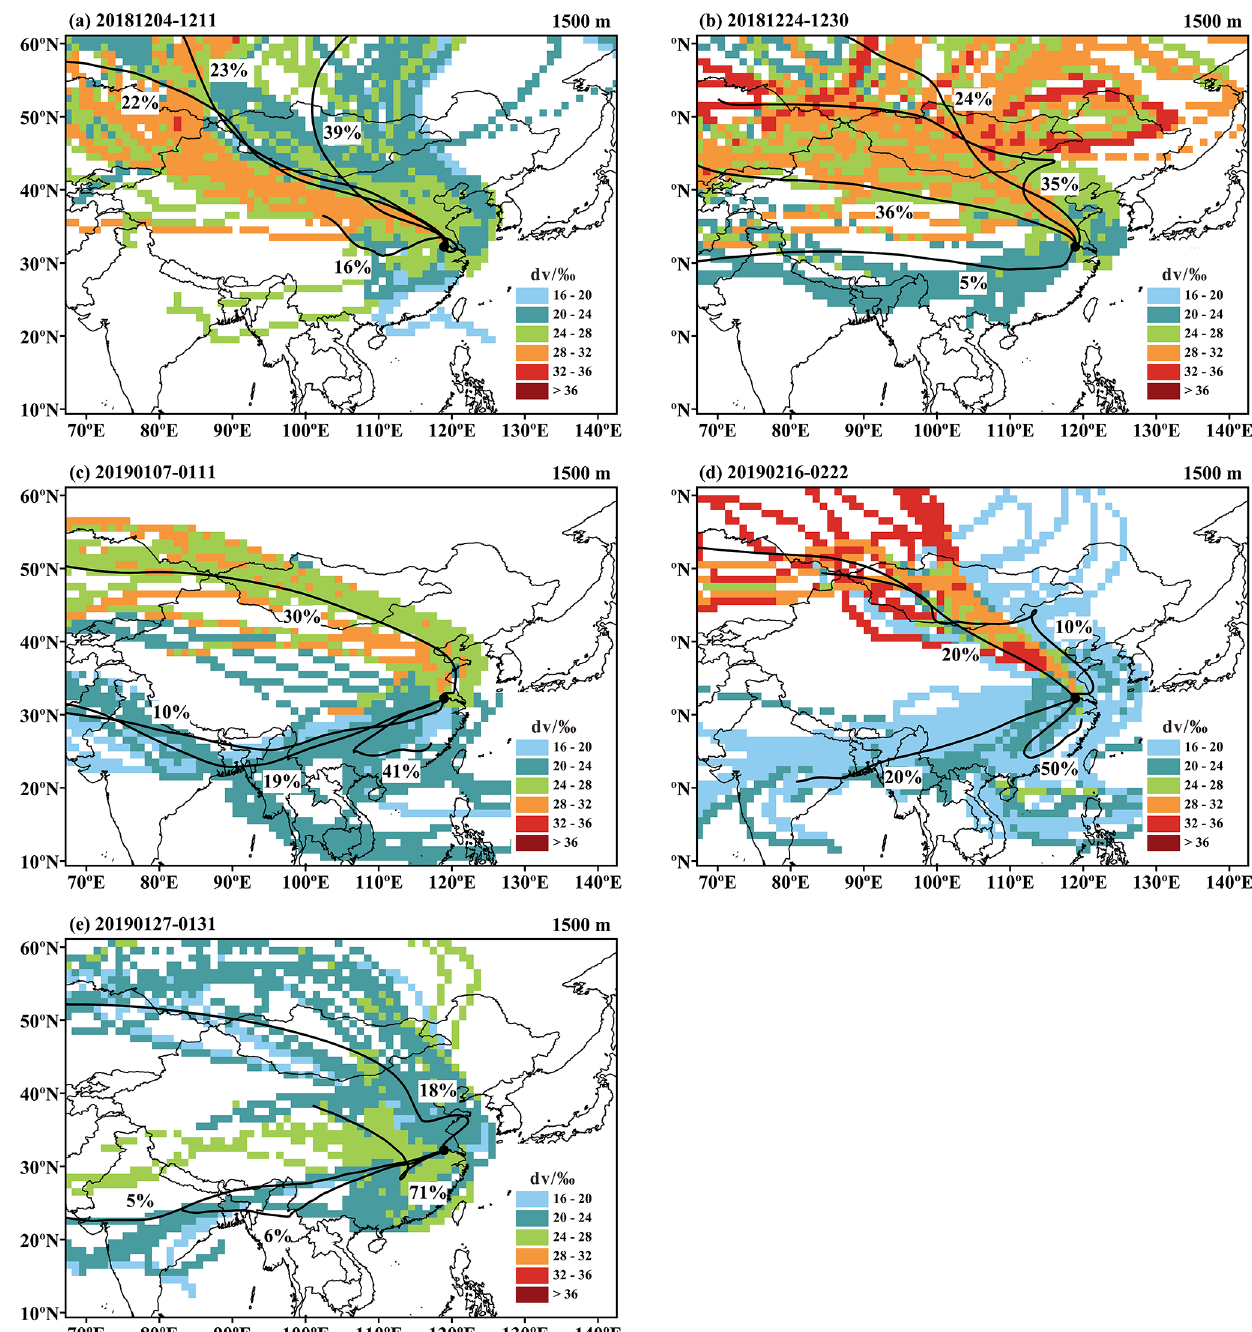
Figure 5. Concentration field of water vapor d v for 192h HYSPLIT back trajectories and clusters for the five typical precipitation events. The black circle indicates the location of